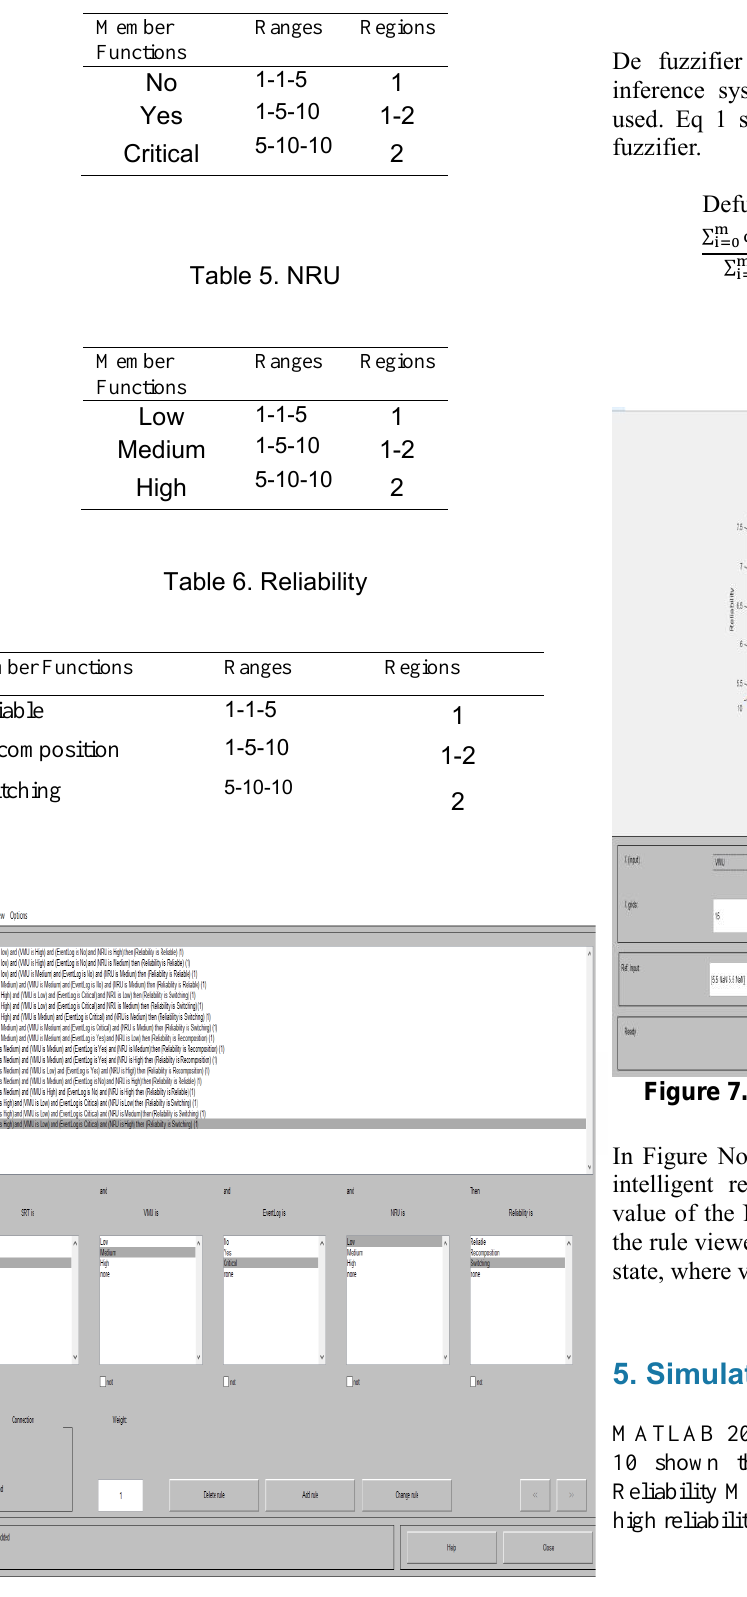
Figure 6. Rule base for Proposed IRM